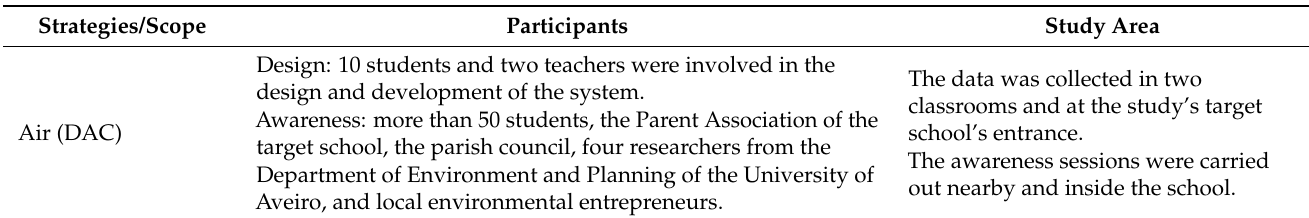
Table 9. Citizen sciences strategies—use of sensors to collect